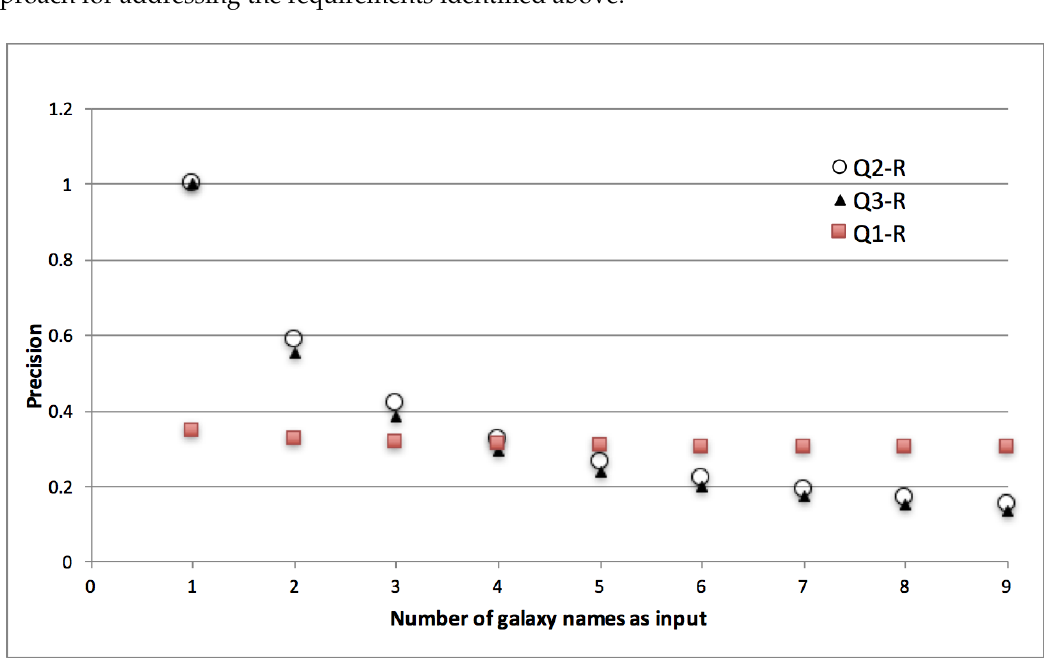
Figure 6. Precision of results when queries are run over generic